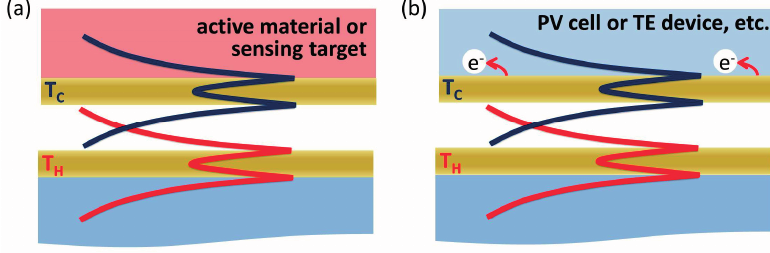
Figure 11. Schematics of possible heat-pumped SPP-mediated platforms for ( a )